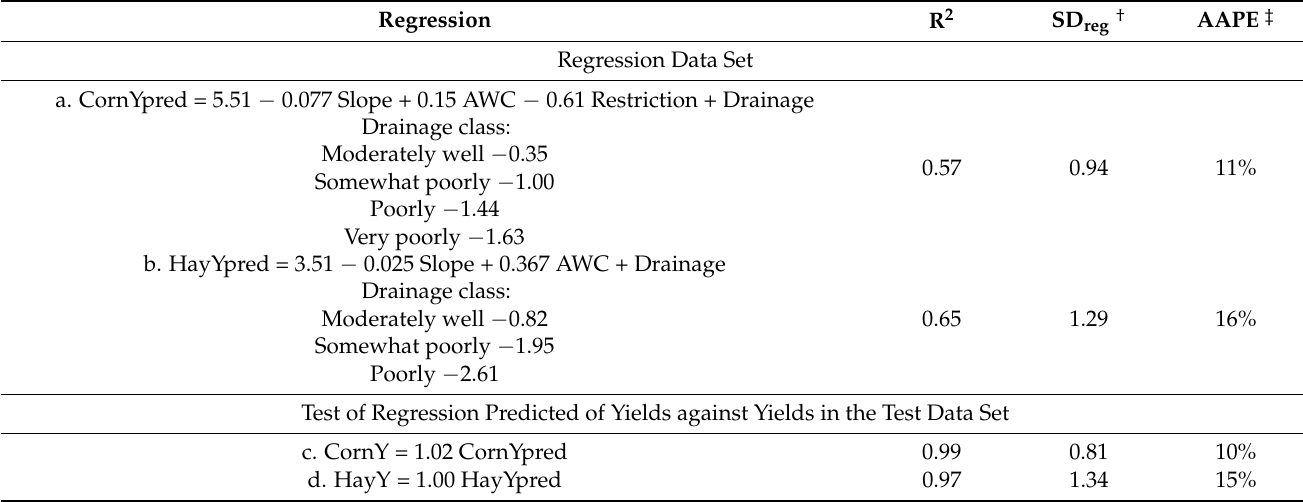
Table 5. The regression of expected yield (MT · ha − 1 ) to soil physical properties for a subset of soils (regression data set) used to predict expected crop yields on other soils based on their physical properties (test data set). The predicted yields (CornYpred, HayYpred) were then tested by regression against the reported yields (CornY, HayY) in the test data set ( n = 89). Regression R 2 SD reg † AAPE ‡ Regression Data